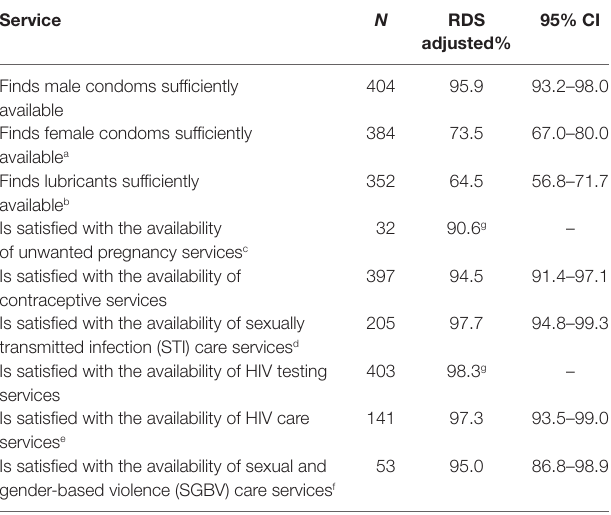
TaBle 6 | Satisfaction with the availability of sexual and reproductive health (SRH)